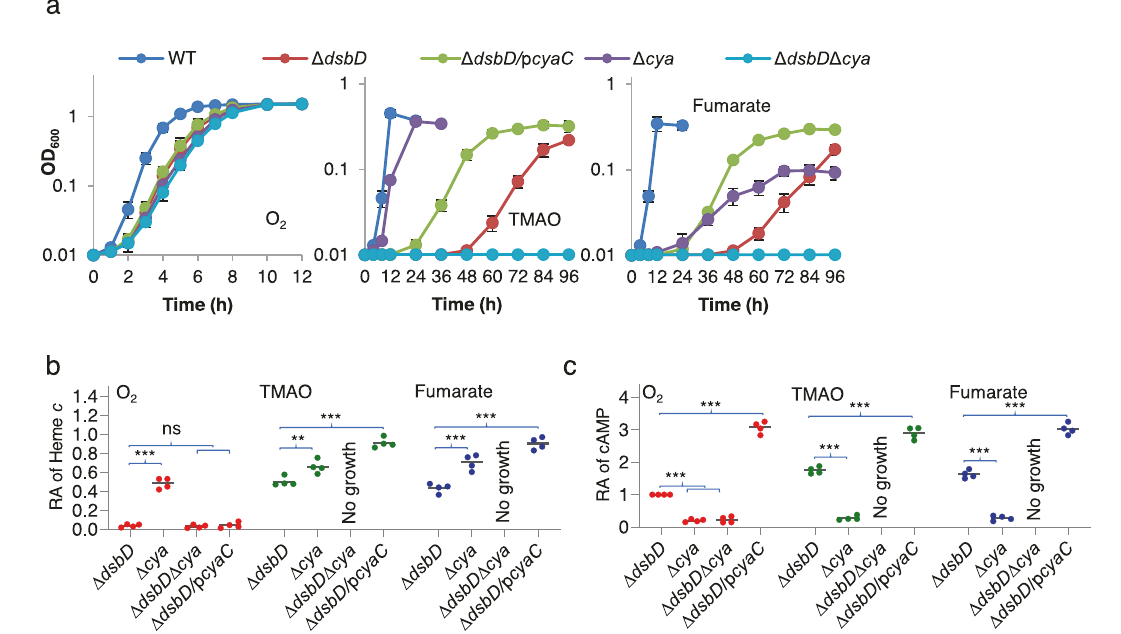
Fig. 3 cAMP is involved in the anaerobic growth of the S. oneidensis dsbD mutant. a Growth of indicated strains on EAs speci fi ed. The expression of cyaC (p cyaC ) was driven by IPTG-inducible promoter P tac . Shown was the data in the presence of 0.5 mM IPTG for all panels. The experiments were performed four times, and the data were presented as the average ± SD (error bar). b Heme c levels in strains grown to the early stationary phase. The relative abundance (RA) of heme c was obtained as described in Fig. 2b. c cAMP levels. After cAMP quanti fi cation, the average data of aerobic-growing Δ dsbD cells were set to 1 and relative abundance (RA) of cAMP in other samples was calculated out by normalizing it to that of aerobic-growing Δ dsbD cells. In b and c , asterisks indicate statistically signi fi cant difference of the values compared ( n = 4; ns not signi fi cant, p > 0.05; * P < 0.05; ** P < 0.01; *** P <